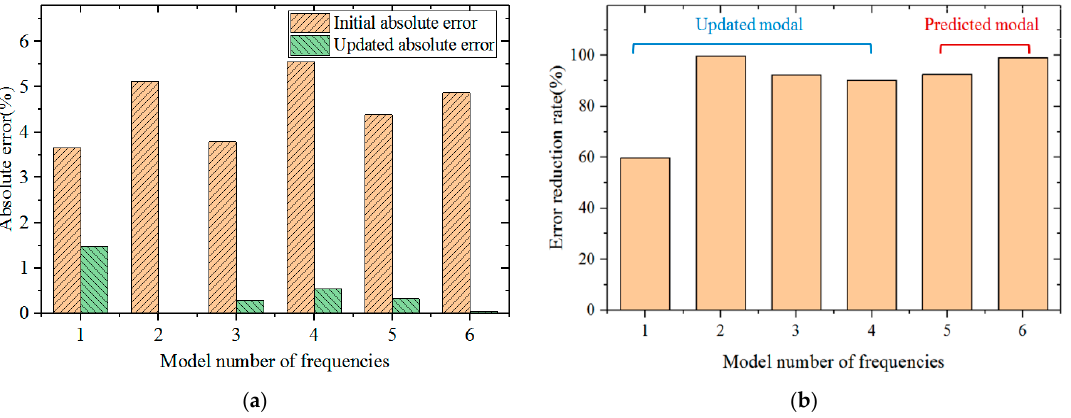
Figure 13. Comparison of error before and after model modification. ( a ) The initial and updated absolute error; ( b ) error reduction rate.